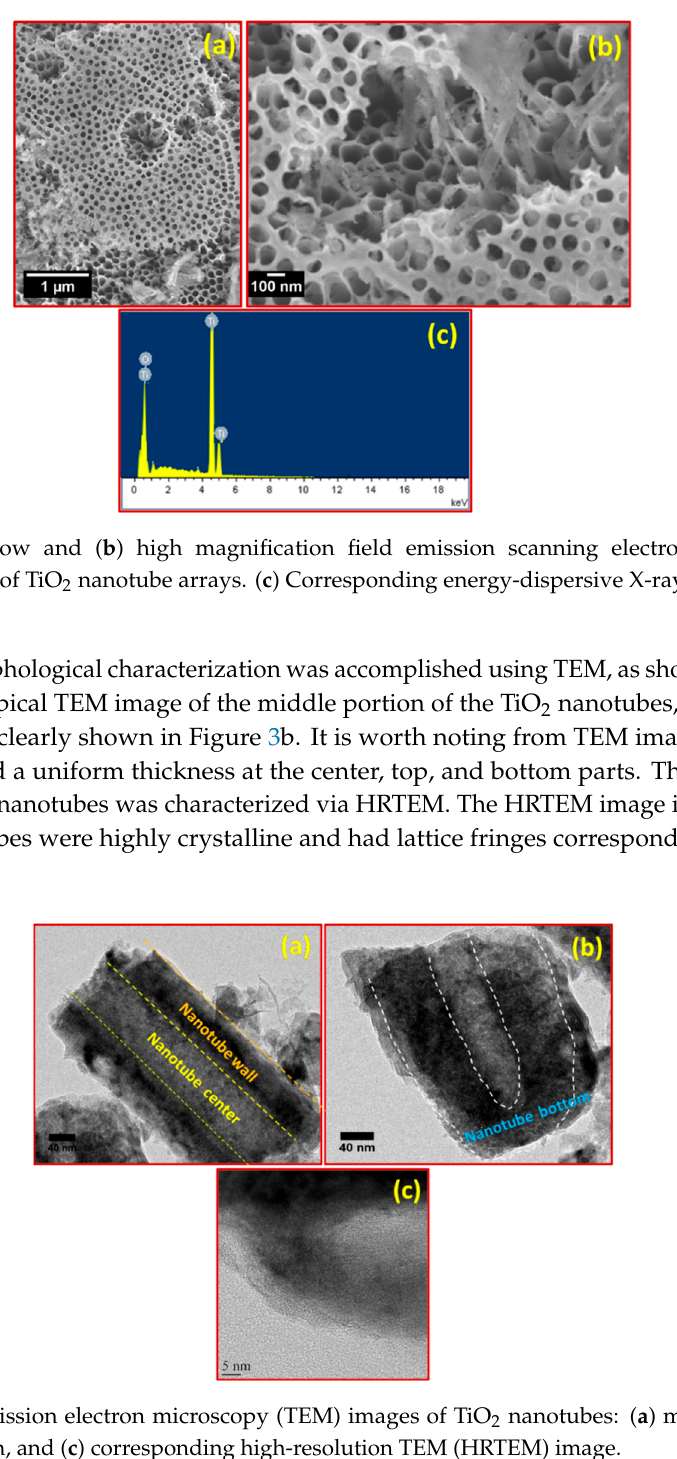
Figure 3. Transmission electron microscopy (TEM) images of TiO 2 nanotubes: ( a ) middle portion, ( b ) bottom portion, and ( c ) corresponding high-resolution TEM (HRTEM) image.